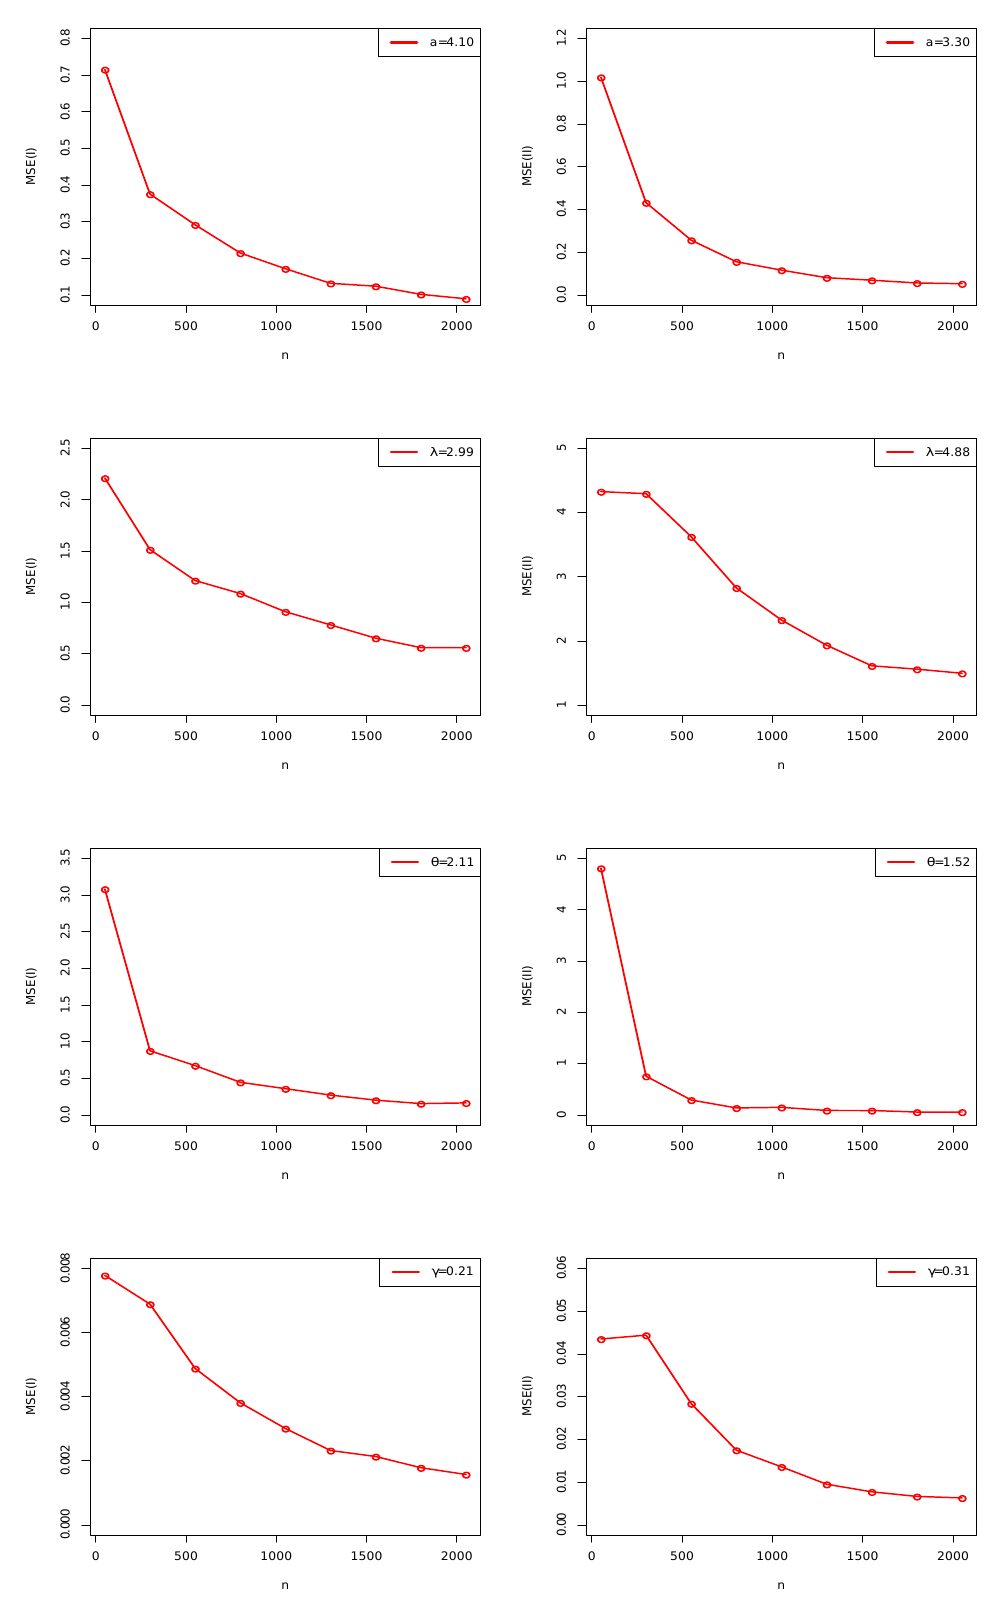
Figure 5. Estimated MSE plots of NGE3ED in